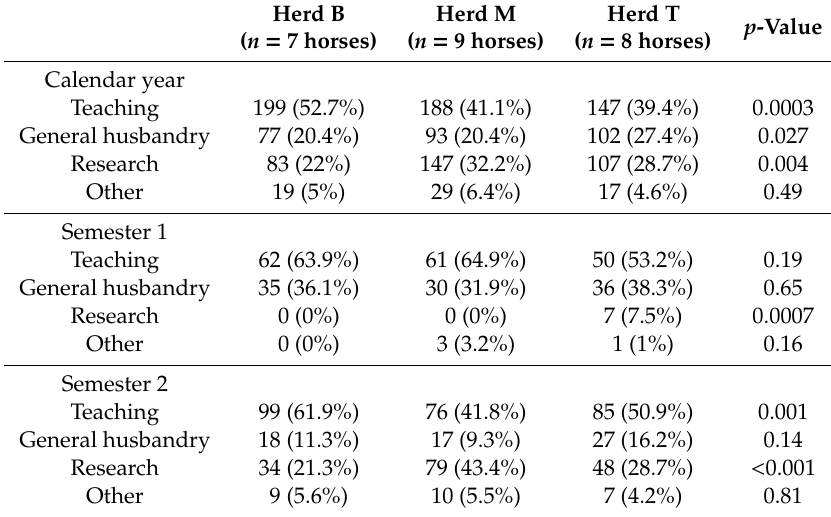
Table 2. The numbers and percentages of horse sessions (i.e., teaching, general husbandry, research and other) for each of the three herds during the 2018 calendar year, and the 1st and 2nd teaching semesters. p -values were obtained from chi-squared tests when comparing the distribution of variables between herds B, M, and T. Herd B ( n = 7